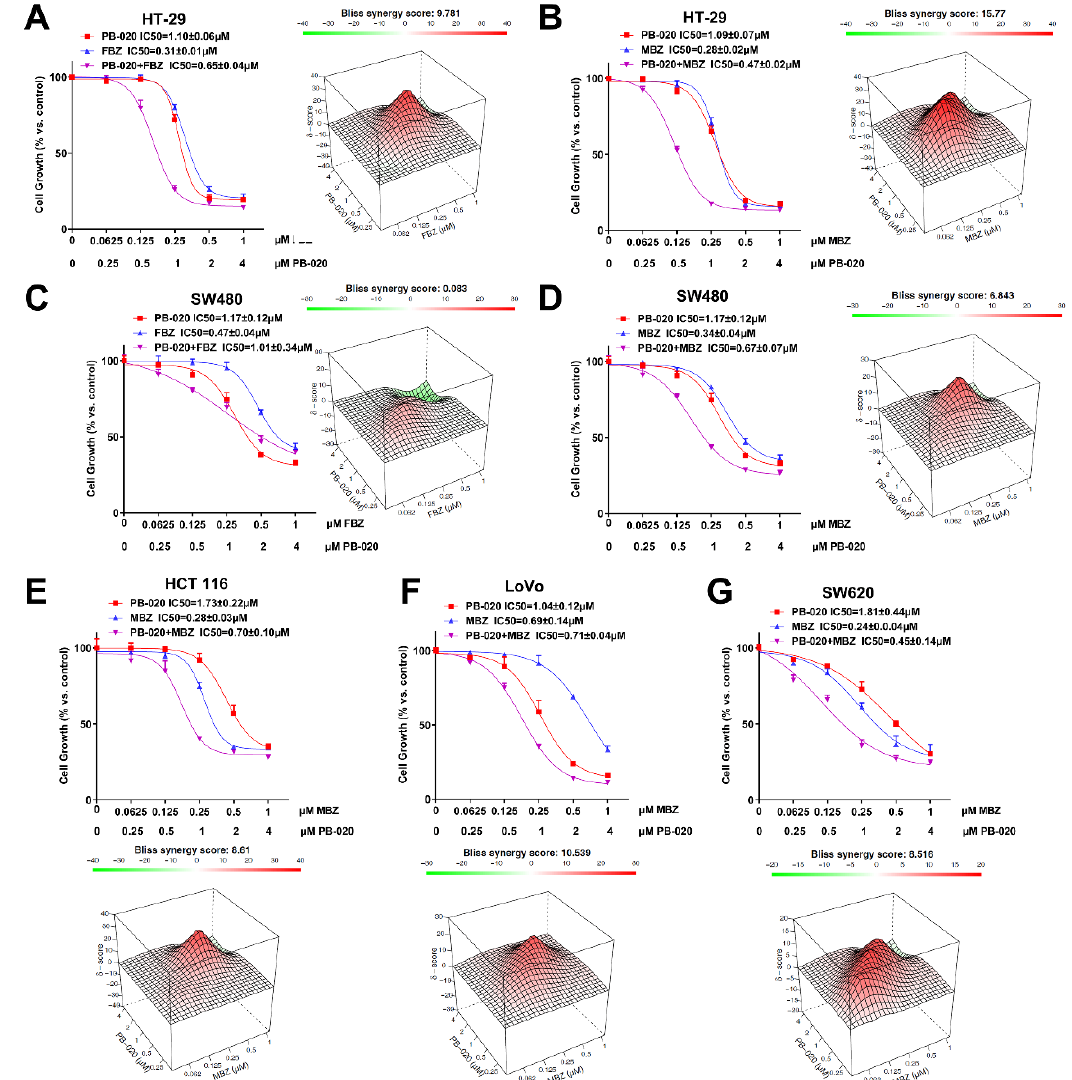
Figure 1. PB-020 in combination with MBZ synergistically reduced the viability of CRC cells. ( A ) HT-29 cells were treated with various concentrations (indicated under the X axis, same below) of PB-020, FBZ and their combination for 72 h, and cell viability was determined using the Cell Counting Kit-8. Bliss independence models were used to analyze the combinatorial inhibitory effect of the combinations. ( B ) HT-29 cells were treated with various concentrations of PB-020, MBZ and their combination for 72 h, and analyzed as in ( A ). ( C ) SW480 cells were treated with various concentrations of PB-020, FBZ and their combination for 72 h, and analyzed as in ( A ). ( D ) SW480 cells were treated with various concentrations of PB-020, MBZ and their combination for 72 h, and analyzed as in ( A ). ( E ) HCT 116 cells were treated with various concentrations of PB-020, MBZ and their combination for 72 h, and analyzed as in ( A ). ( F ) LoVo cells were treated with various concentrations of PB-020, MBZ and their combination for 72 h, and analyzed as in ( A ). ( G ) SW620 cells were treated with various concentrations of PB-020, Taxol and their combination for 72 h, and analyzed as in ( A